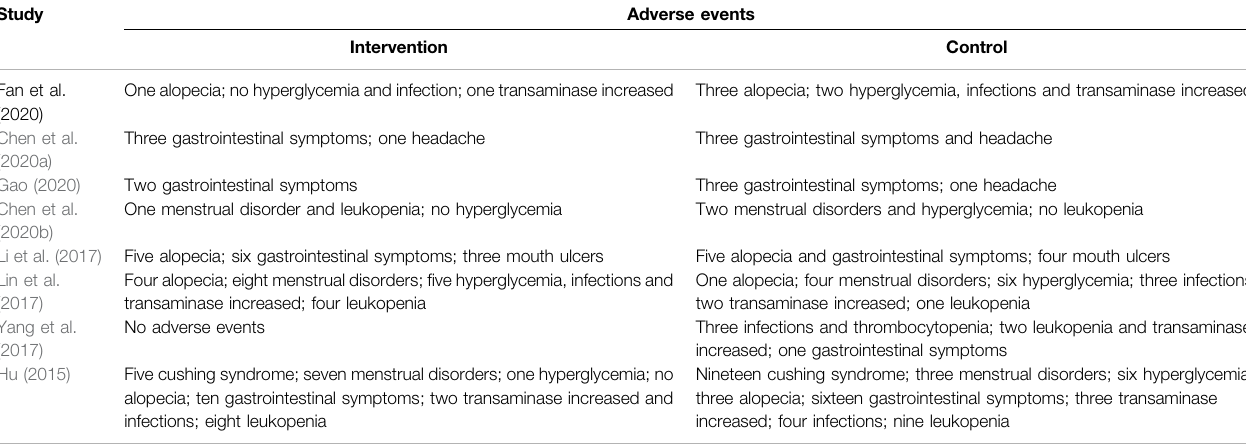
TABLE 2 | Adverse events reported in the